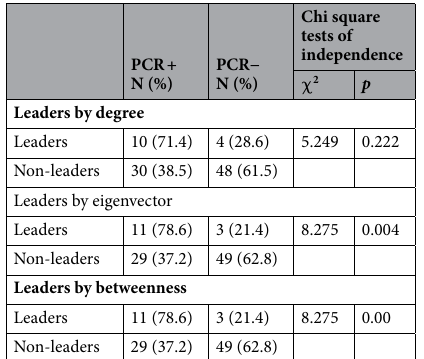
Table 4. Results of the comparison between leaders and non-leaders who had PCR + and PCR− applying the chi-square test of independence.